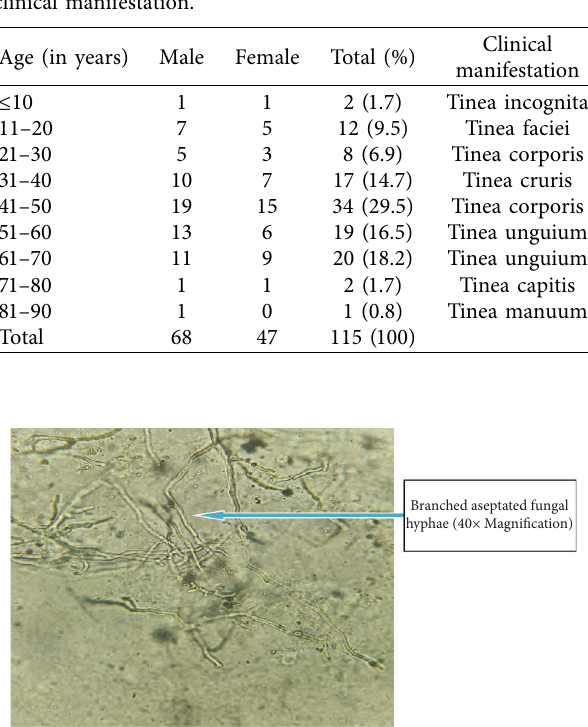
Figure 1: KOH wet-mount of skin sample showing hyaline, branched, aseptate fungal hyphae.